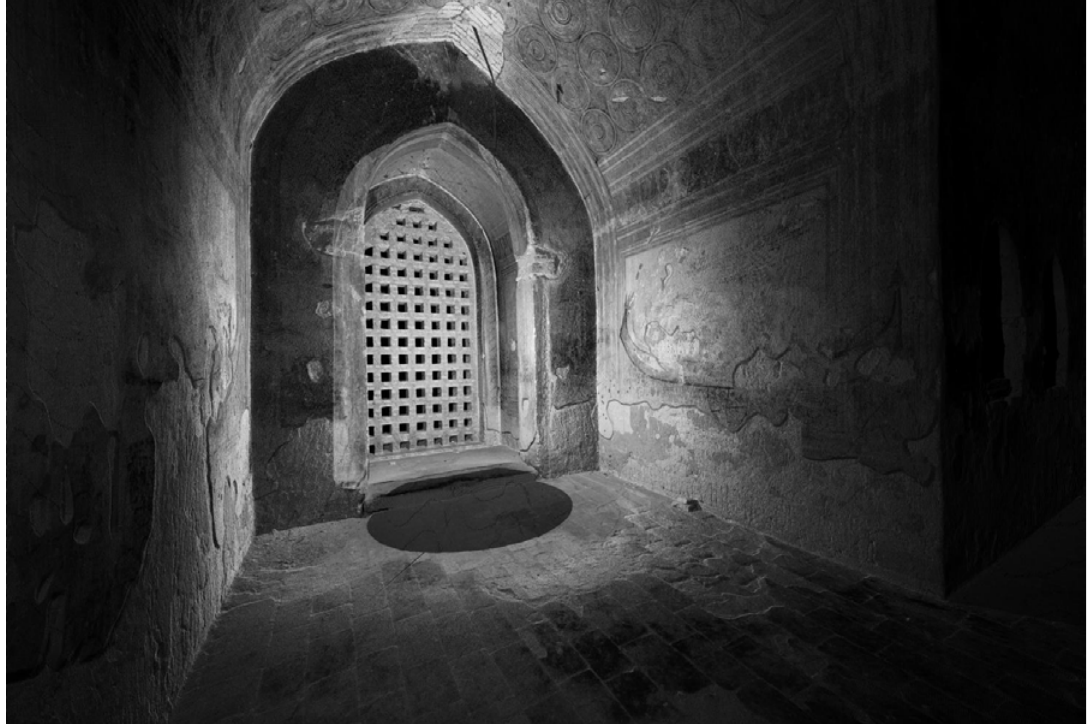
Figure 1. Image of a point cloud from a laser scan taken in